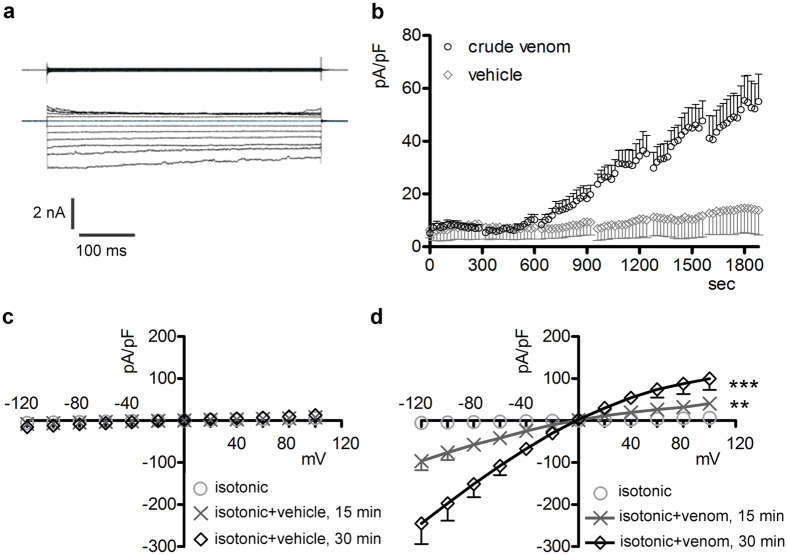
Crude venom elicits an inwardly-rectifying current.(a) Original current recordings obtained from HEK 293 Phoenix cells in whole-cell configuration with pipette solution 1 (Table 2) and bath solution 1 (isotonic, Table 1), before (top panel) and 30 min after addition of 0.025 μg/μl crude venom to the bath solution (lower panel). (b) Current density (pA/pF) to time (sec) and (c,d) current density (pA/pF) to voltage (mV) relationship recorded in isotonic solution before, 15 and 30 min after the addition of the vehicle (left; n = 11) or crude venom (right; n = 12) to the bath solution. **, ***p < 0.01, p < 0.001 compared to vehicle at all applied voltages except 0 mV, unpaired Student’s t test. In (b) p < 0.05 for time points > 900 sec.